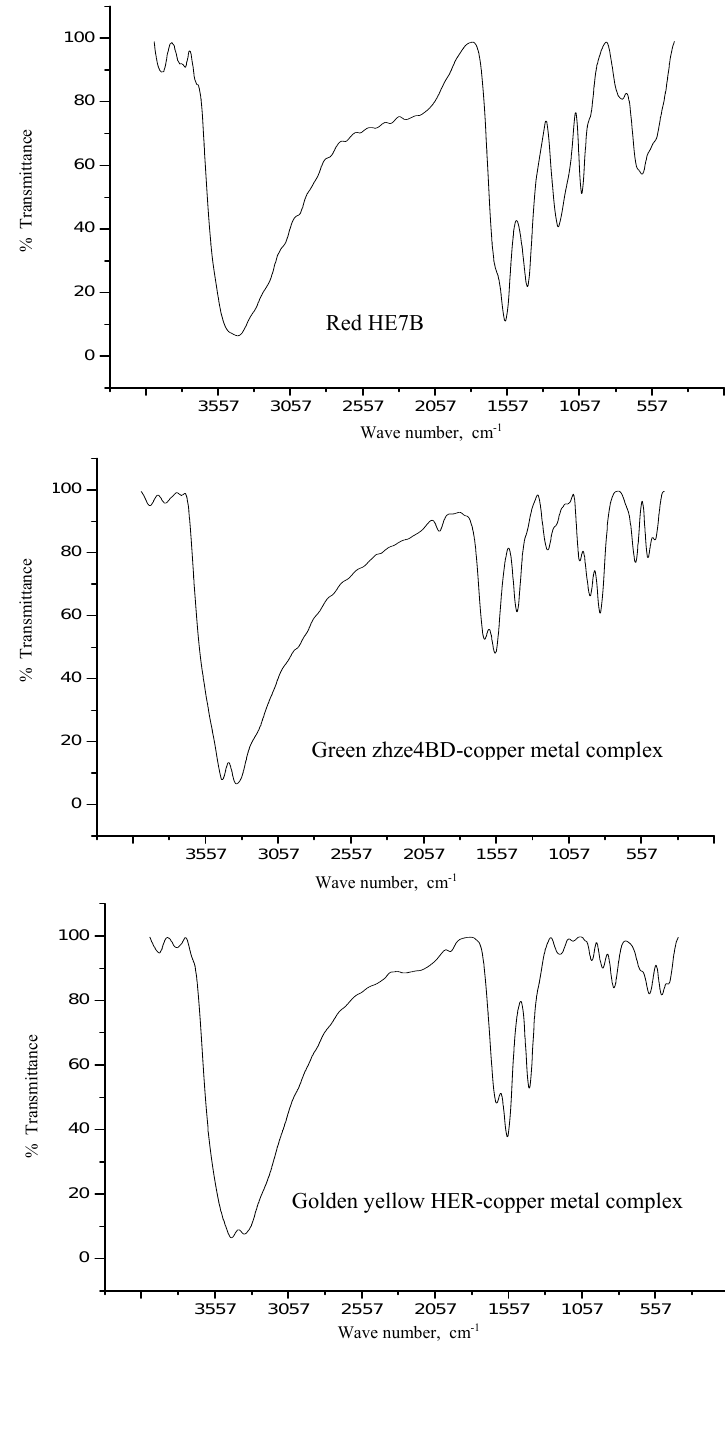
Golden yellow HER-copper metal